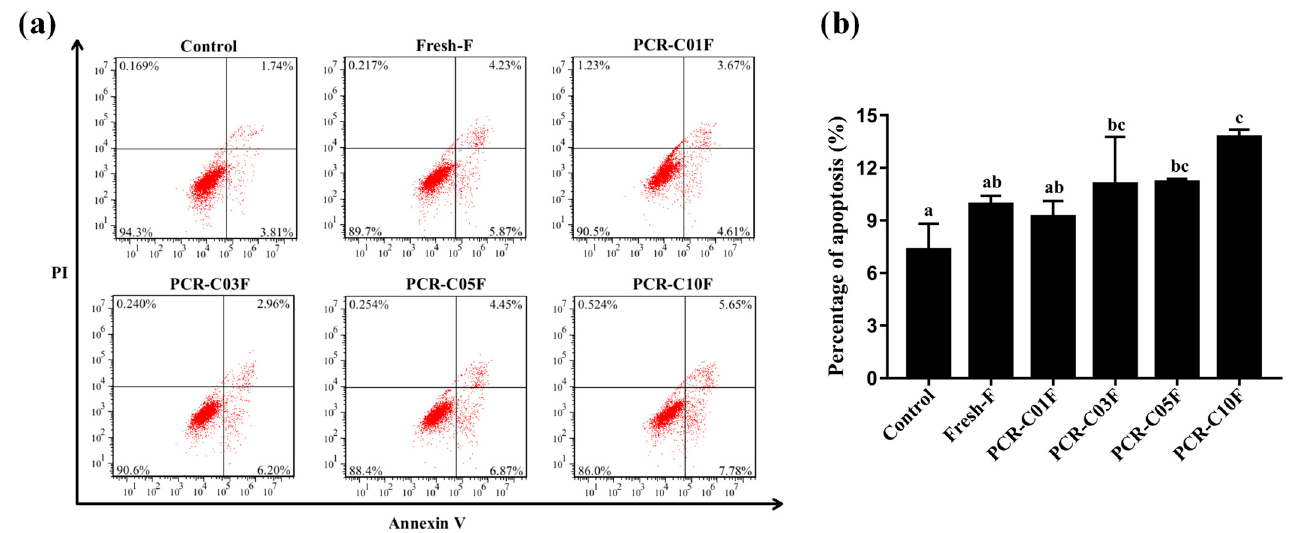
Figure 5. PCR-CF-induced apoptosis of A549 cells. ( a ) The effect of PCR-CF on apoptosis of A549 cells. The apoptosis rate of A549 cells with or without 24-h PCR-CF (200 µ g/mL) treatment followed by Annexin V-FITC/PI double staining was measured by flow cytometry. ( b ) The apoptosis rate of A549 cells was calculated (early and late apoptosis). The data were expressed as the means ± SD of the triplicates of each independent experiment. The different lowercase letters above the bars indicated a significant difference ( p < 0.05) between the different groups through one ‐ way ANOVA and Duncan’s multiple comparisons.